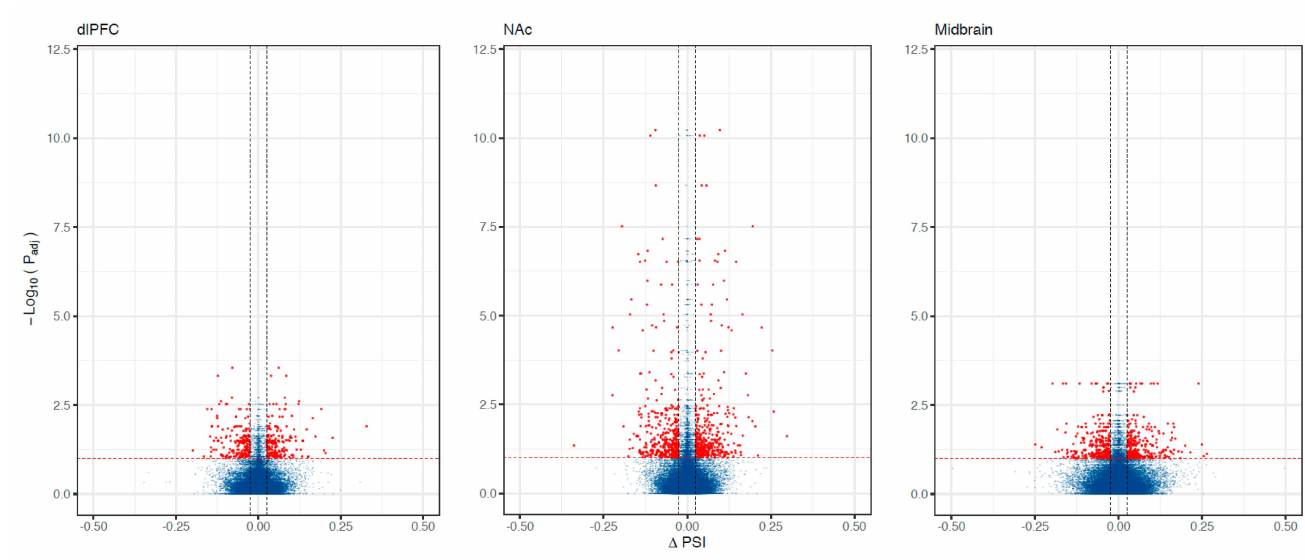
Figure 1. Alternative splicing associations with OUD across brain regions. Volcano plots showing differentially spliced genes associated with OUD. The X-axis shows ∆ PSI (splicing effect size) and the y-axis indicates the level of significance ( − log 10 P adj ). Each dot corresponds to a specific splicing event within a gene. Red dots are significant (P adj < 0.10 and | ∆ PSI| > 0.025).